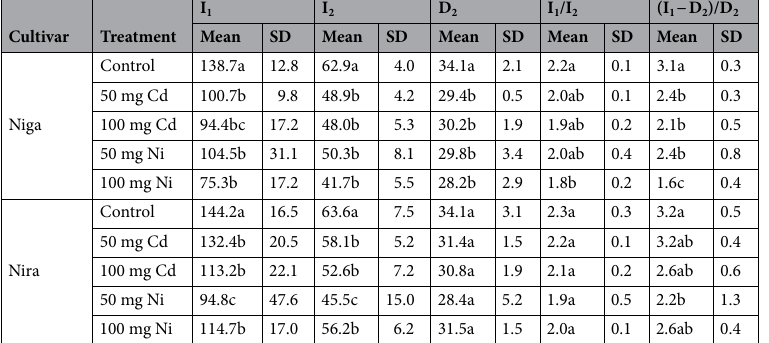
Table 3. (I 1 − D 2 )/D 2 and I 1 /I 2 ratios ± S.D. [relative units] of two perennial ryegrass turf cultivars (‘Niga’ and ‘Nira’) under different Ni and Cd treatment (0; 50 and 100 mg × 100 g −1 of substrate). Means within one cultivar marked by different letters represent significant differences ( p < 0.05, n =